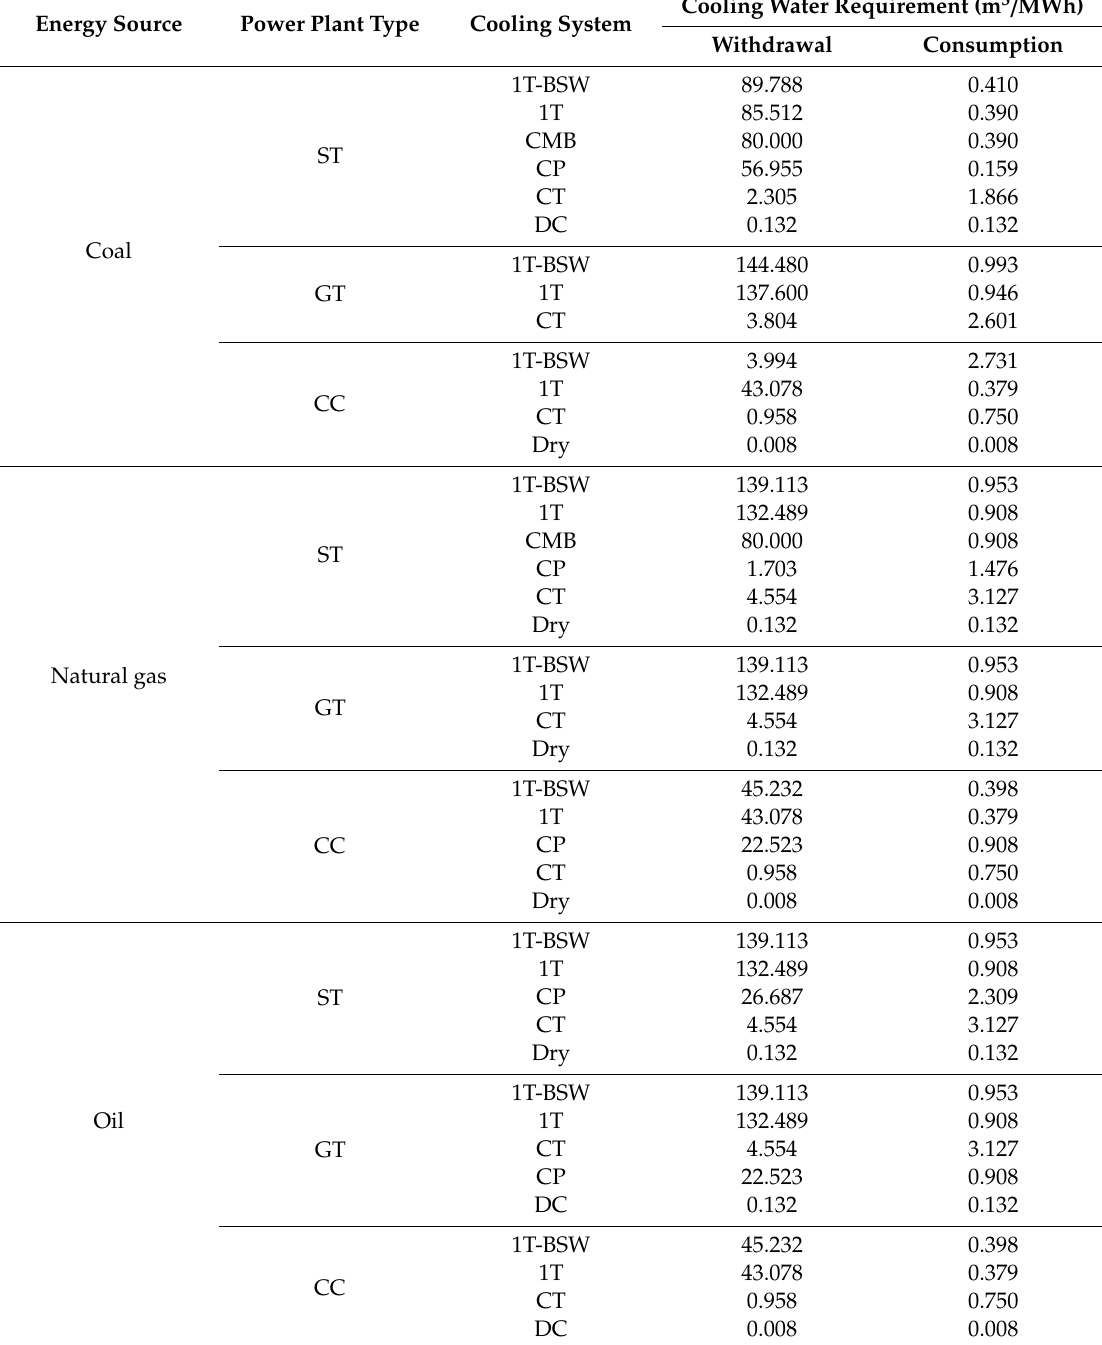
Table A1. Applied water use intensity per unit of electricity output (m 3 / MWh) by energy source and generation technology. The sole responsibility for the content of this paper lies with the